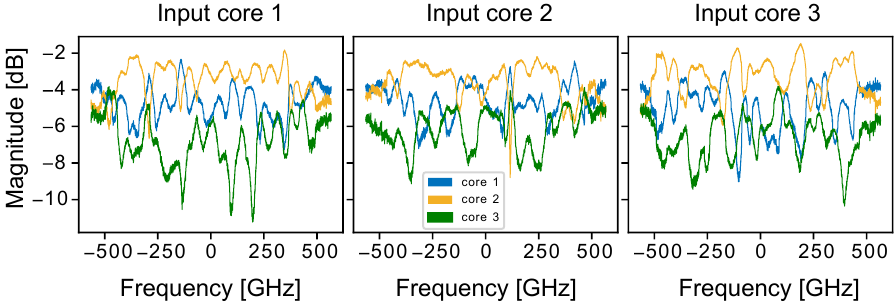
Figure 10. Stitched magnitudes of the transfer function extracted from 45 spectral comb windows with light entering the different cores in the respective graphs, and the exit cores are shown in different colors